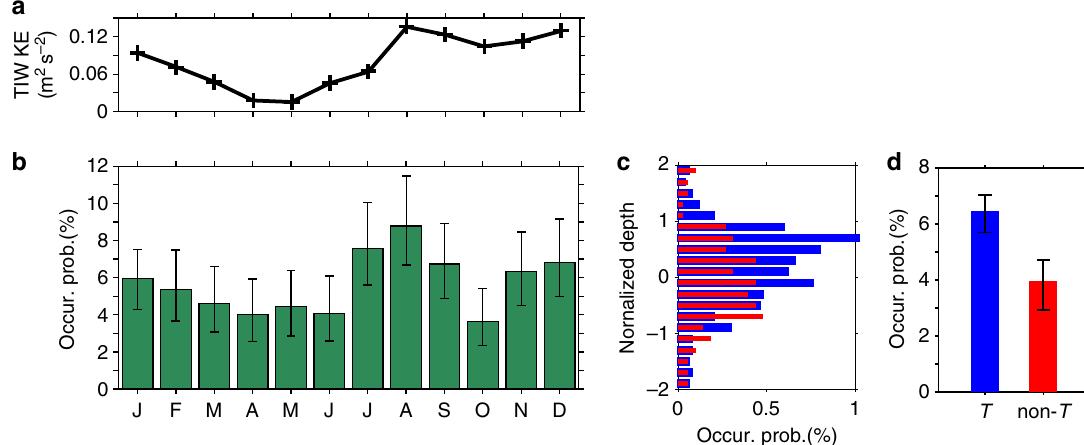
Figure 2 | Occurrence probability of detected overturns and its relation to tropical instability waves. ( a ) Monthly climatology of TIWs KE (averaged over years 2005–2011). ( b ) Monthly occurrence probability of overturns between 3 (cid:2) S and 6 (cid:2) N over 160 and 270 (cid:2) W; error bars are 95% bootstrap CIs. Peak at August is significantly different from surrounding troughs in June and October at the 95% bootstrap confidence level; the peak in December is significantly different from the trough at October at the 95% bootstrap confidence level and from troughs in April and June at the 90% bootstrap confidence level. The correlation coefficient between monthly TIWs KE in a and occurrence probability in b is r ¼ 0.66, with P -value ¼ 0.020 and 95% CI ¼ (0.14, 0.89), that is, statistically significant. ( c ) Histogram of the occurrence probability in the normalized coordinate for periods of TIW (blue) and non-TIW (red) (see text). ( d ) Total occurrence probability of overturns during TIW (6.34%, blue) and non-TIW (3.76%, red) periods; error bars are 95% bootstrap CIs (blue: (5.67%, 7.07%) and red: (2.92%, 4.71%)). In b , c and d , the occurrence probability is calculated over the years